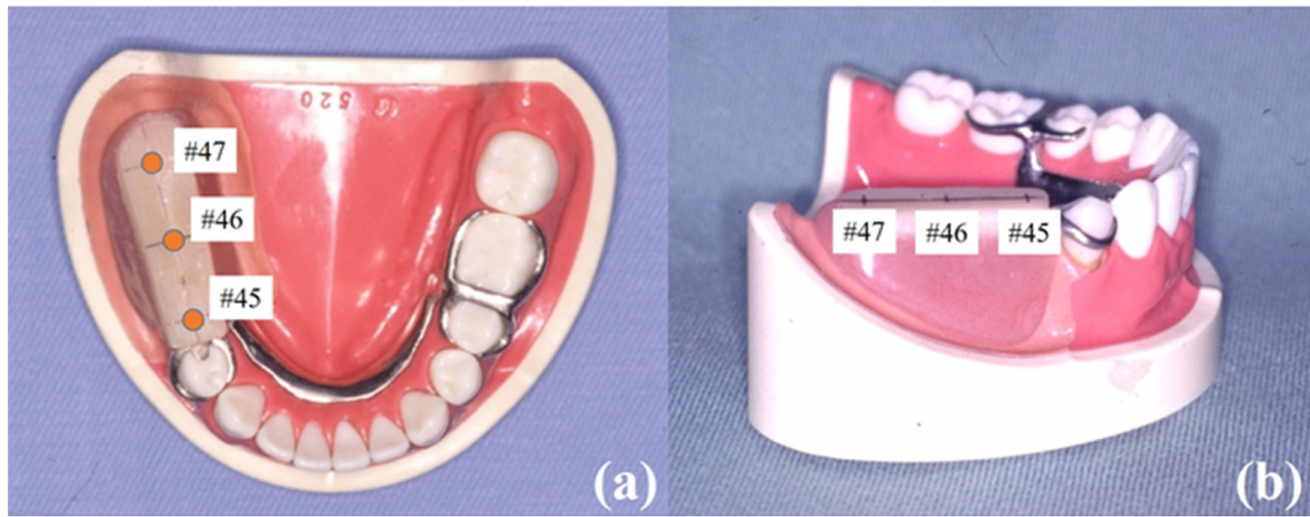
Figure 2. Images of simulated mandible model with a removable partial denture and loading points. ( a ) Occlusal view; ( b ) sagittal